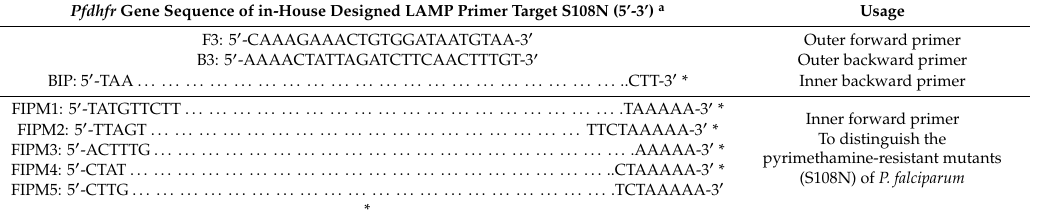
Table 1. In-house designed LAMP primers of Pfdhfr gene targeting S108N codon.